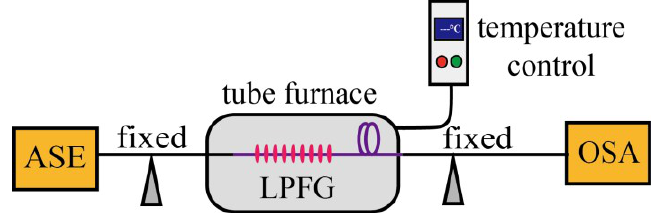
Figure 5. Experiment setup for testing the temperature response of the LPFG.